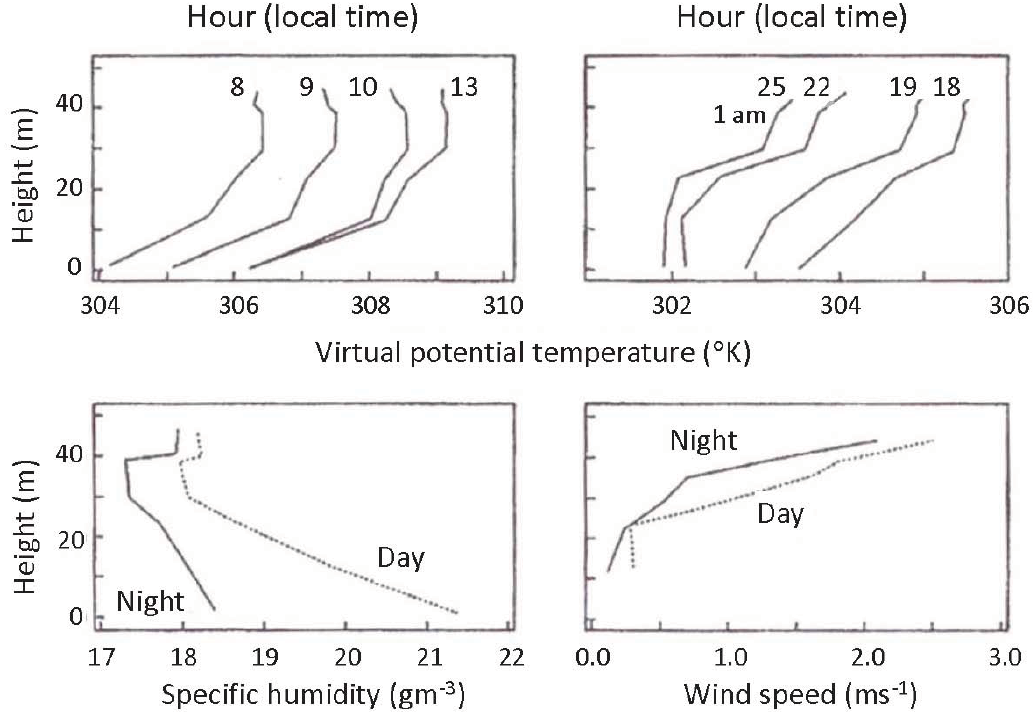
Figure 1. Mean values of rain forest meteorological conditions. Mean profiles of virtual potential temperature, (cid:2) (°K) (top panels), specific humidity, q (gm (cid:3)3 ) (night is solid, day v is dotted) (lower left-hand side), and wind speed, U (ms (cid:3)1 ) (night is solid, day is dotted) profiles are identified by the (lower right-hand side) within a 45 m high rainforest. The (cid:2) v hour of day over which they were averaged (12 = 1200; 25 = 0100, local time)